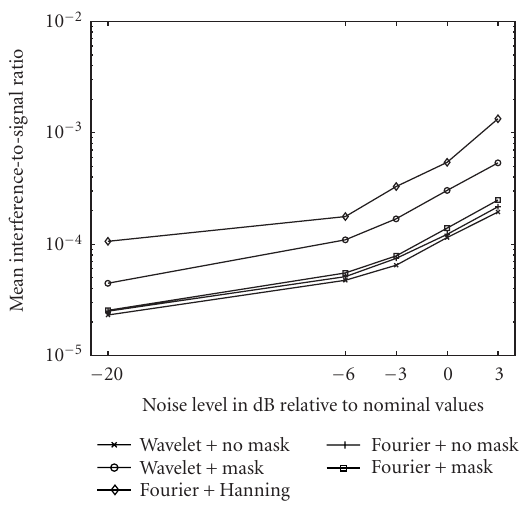
Figure 12: Comparison of the mean ISR for SZ as a function of noise in five di ff erent configurations, namely, wSMICA without mask, wSMICA with mask, fSMICA without mask, fSMICA with mask, and fSMICA with Hanning apodizing